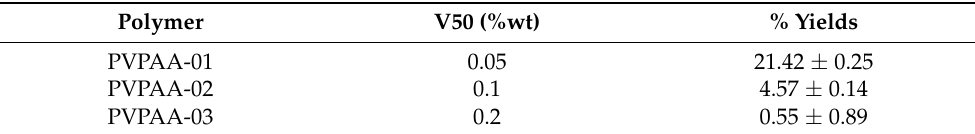
Table 1. Synthesis yields of PVPAA.